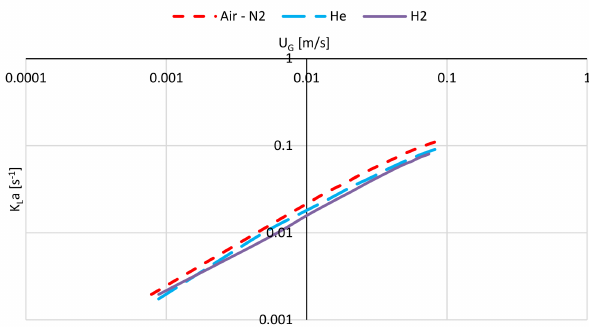
Figure 38. Influence of the gas phase on k L a —data from Ozturk et al. [173].